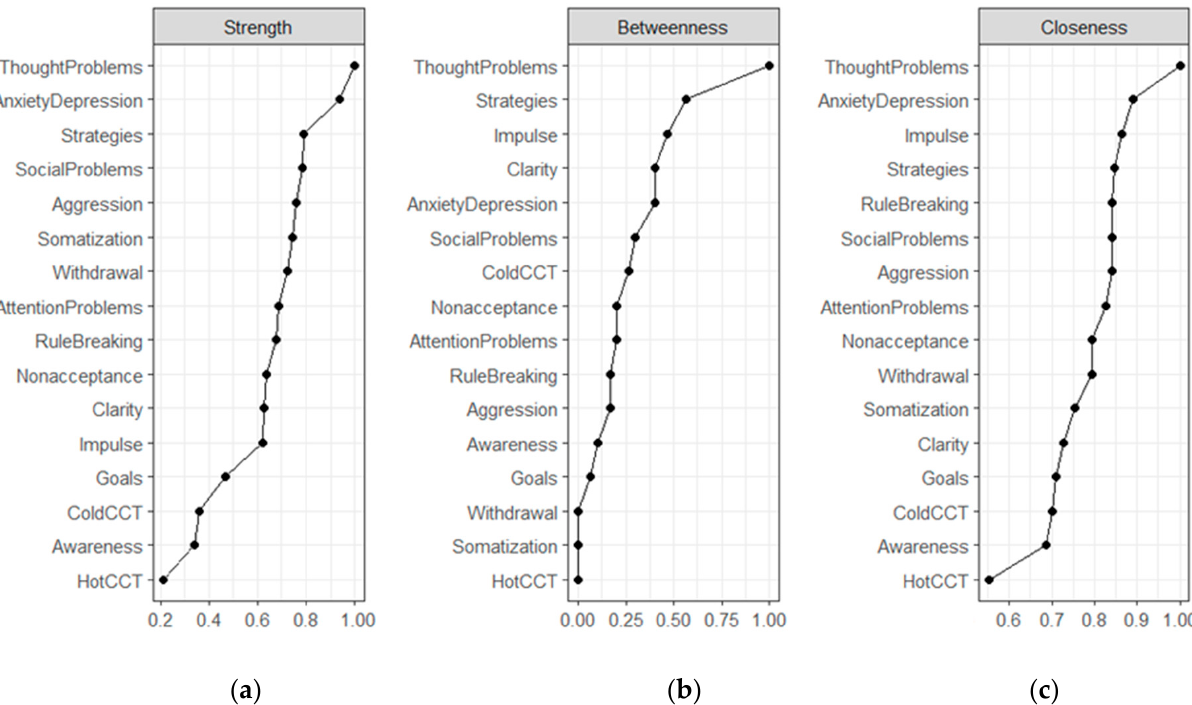
Figure 4. Node strength ( a ), betweenness ( b ), and closeness centrality ( c ) estimates for eight syndrome scales of the Youth Self-Report (YSR), six subscales of the Difficulties in Emotion Regulation Strategies (DERS), and risk propensity in the decision-making tasks.